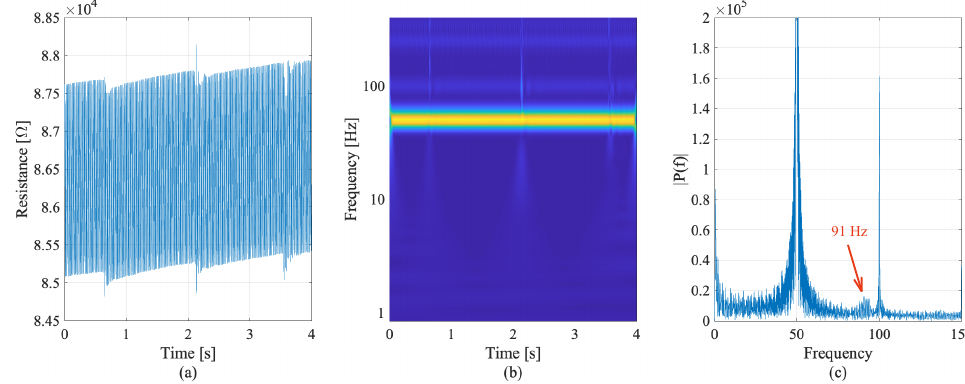
Figure 11. Resistance time history ( a ), frequency–time analysis ( b ) and frequency response ( c ) of first embedded smart concrete cube sensor during hammer hit tests.